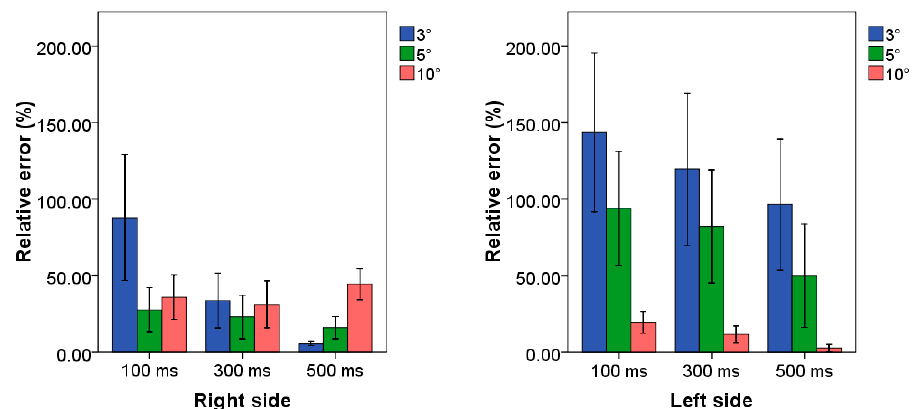
Figure 4. Mean value and standard deviation of relative error related to the case study at medium frequency for both side of all combinations of TB procedure. Blue, green and red bars represent the combination in which the threshold amplitude is set to 3°, 5° and 10°, respectively. Clusters on the x -axis represent the possible time threshold value. Each bar corresponds to a specific combination among the nine tested algorithms.